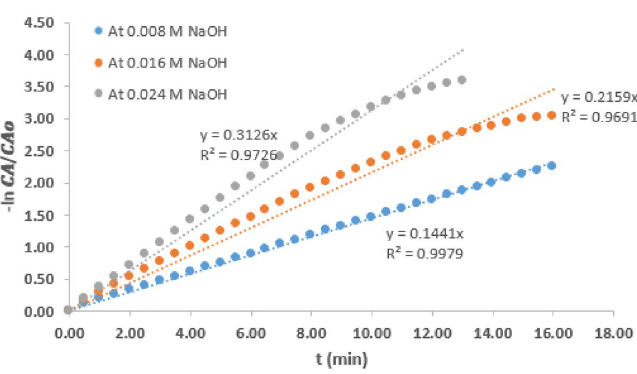
C A Figure 5. − ln C Ao vs time graph for hydrolysis of CV at 21 °C and variable concentration of